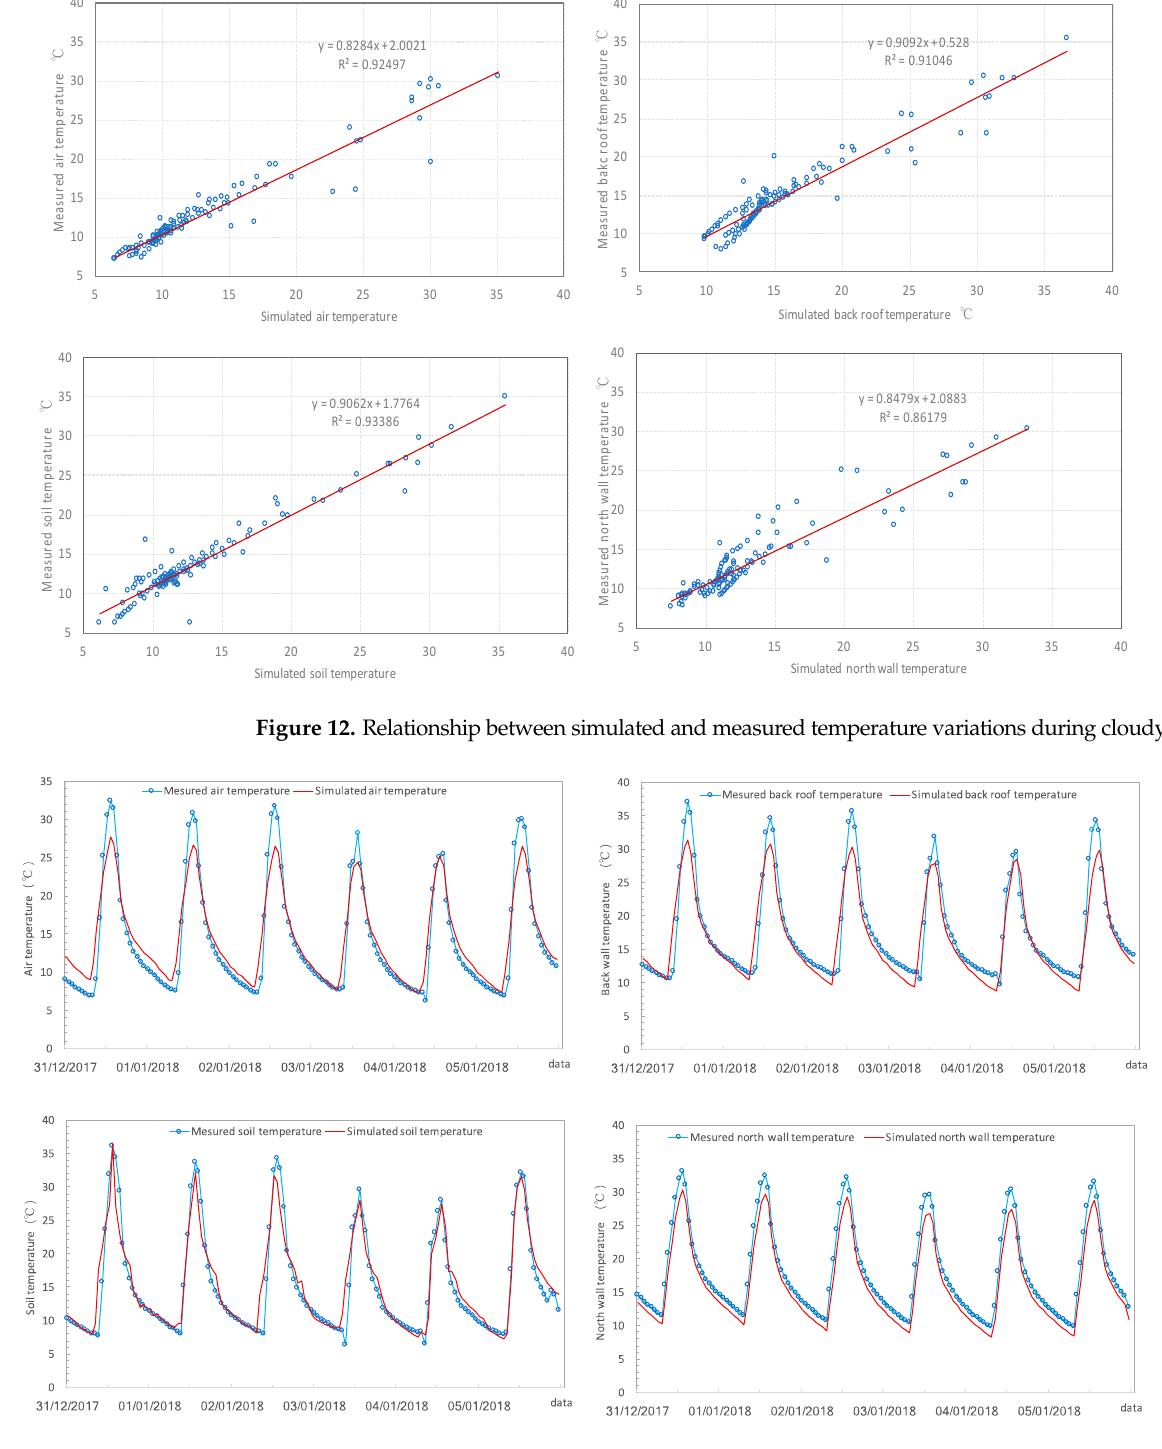
Figure 13. Comparisons of simulated and measured temperature variations during clear days.